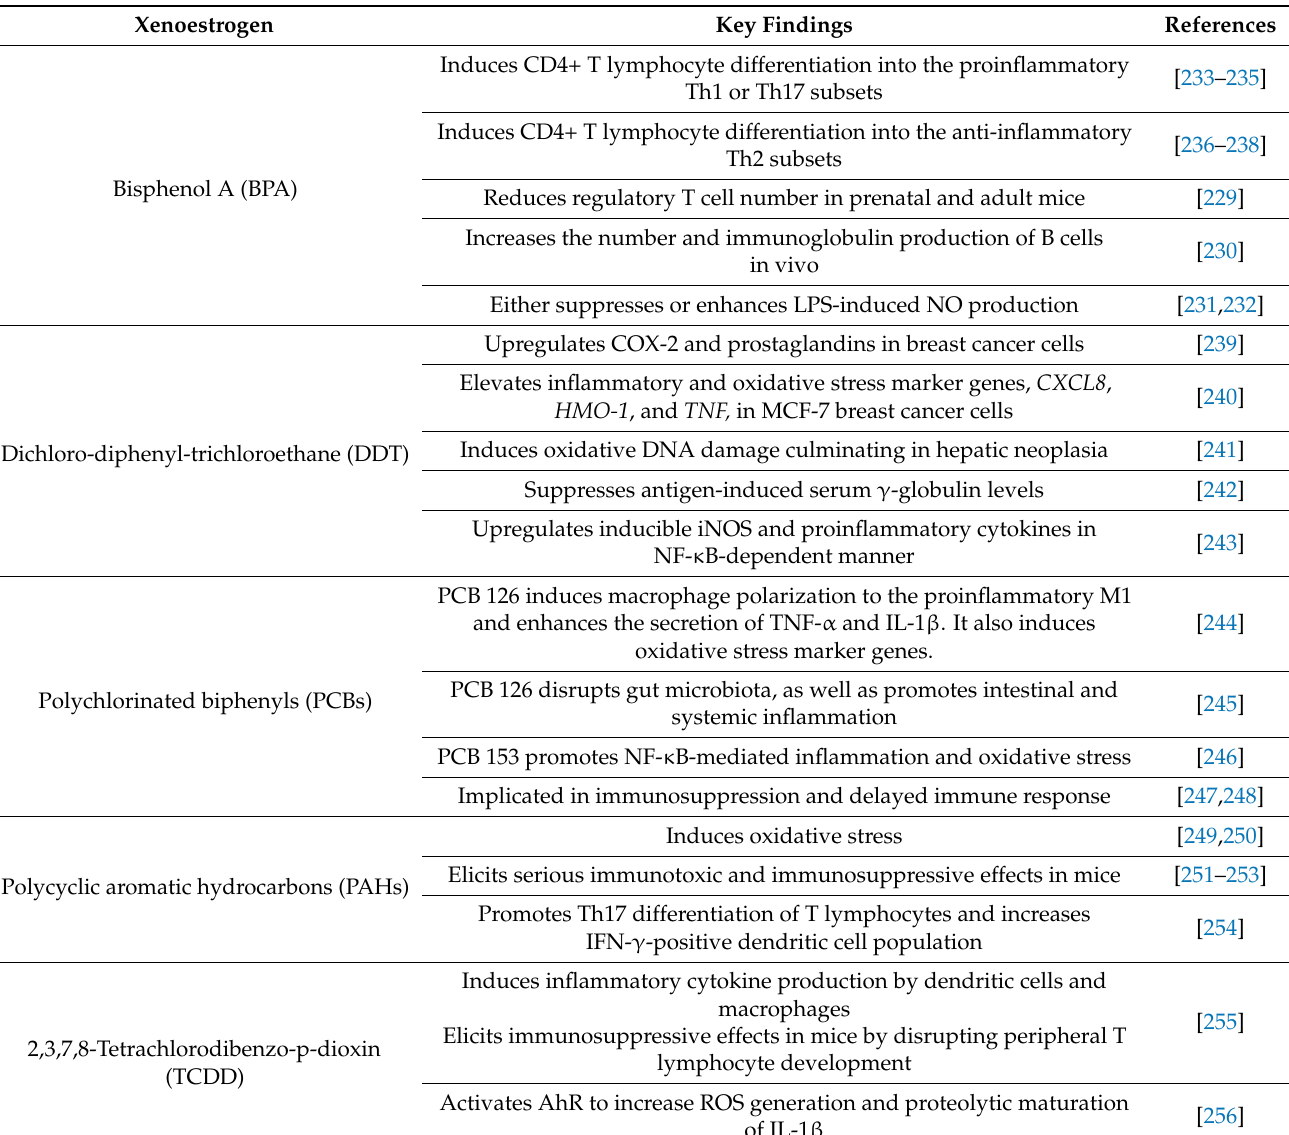
Table 3. Effects of synthetic xenoestrogens on inflammation and immune